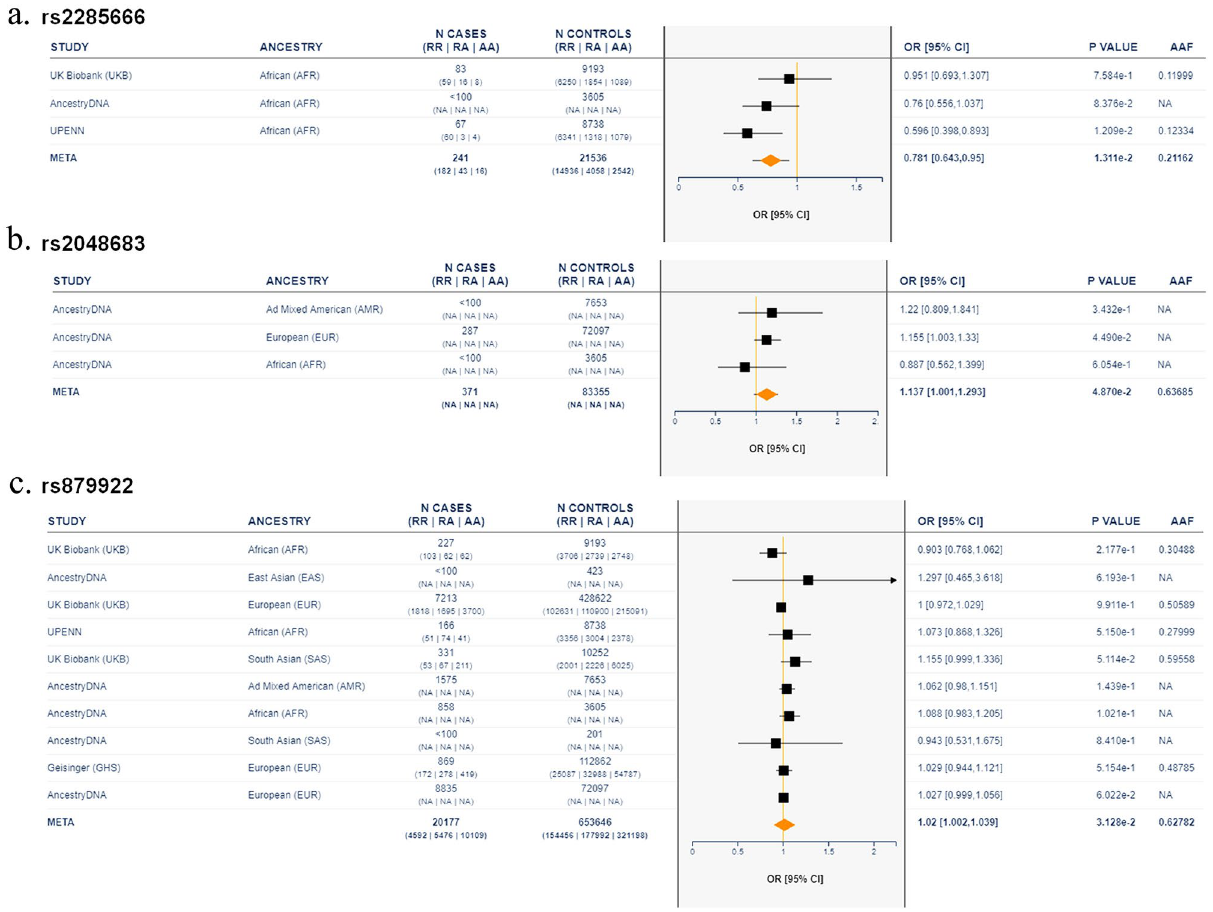
Figure 4. Association between COVID-19 outcomes and the most significant variants: rs2285666, rs2048683, and rs879922. Results combined across cohorts using an inverse variance meta-analysis showing Odd ratios (Confidence interval; [95% CI) for ( a ) rs2285666 (n = 241 COVID-19-positive cases, n = 21,536 COVID- 19-negative), ( b ) rs2048683 (n = 371 COVID-19-positive cases, n = 83,355 COVID-19-negative), and ( c ) rs879922(n = 20,177 COVID-19-positive cases, n = 653,646 COVID-19-negative). RR, individuals who have genotype reference/reference for all variants included in burden test; RA, individuals who have genotype reference/alternate for at least one variant; AA, individuals who have genotype alternate/alternate for at least one variant; AAF, alternative allele